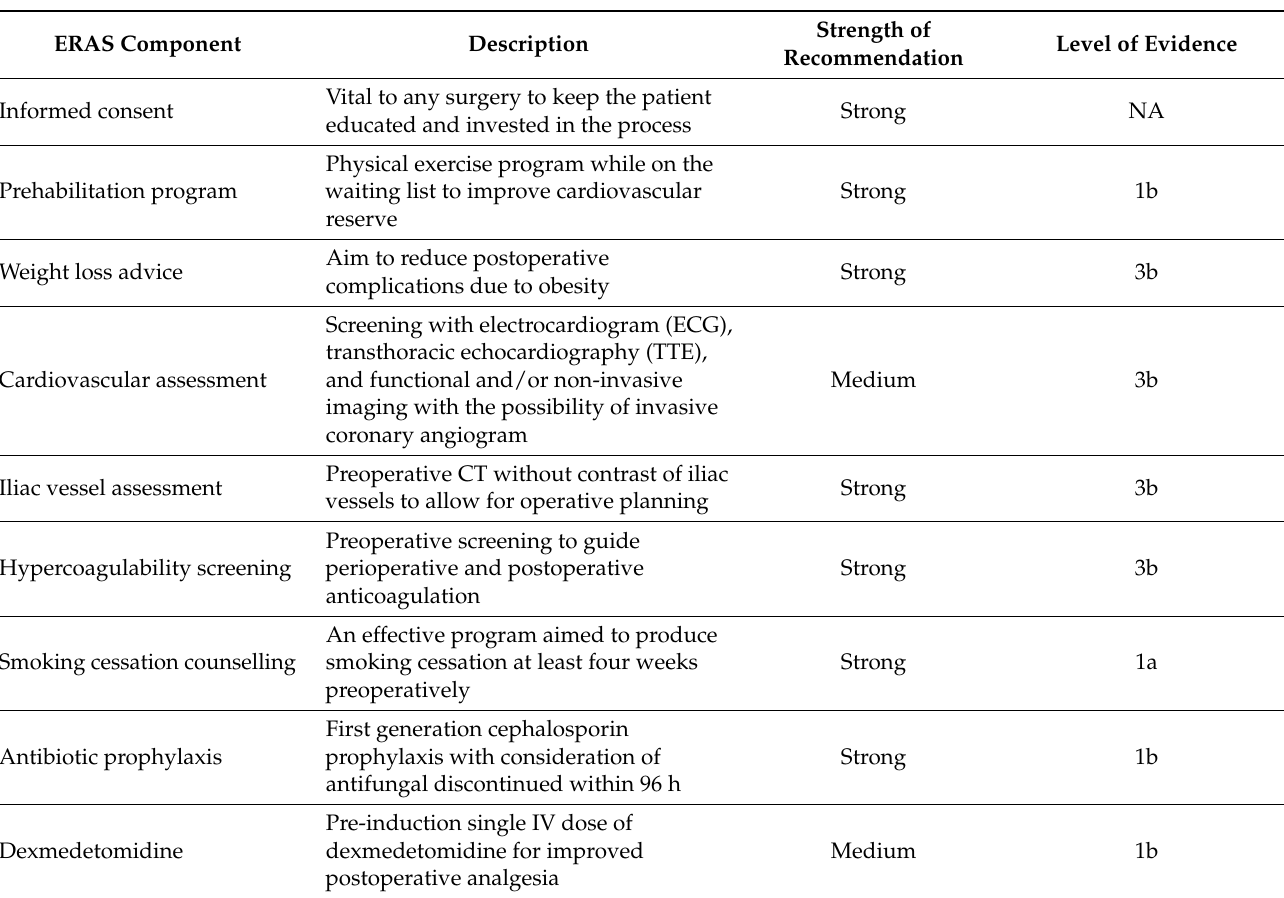
Table 1. Proposed enhanced recovery after surgery (ERAS) component for pancreatic